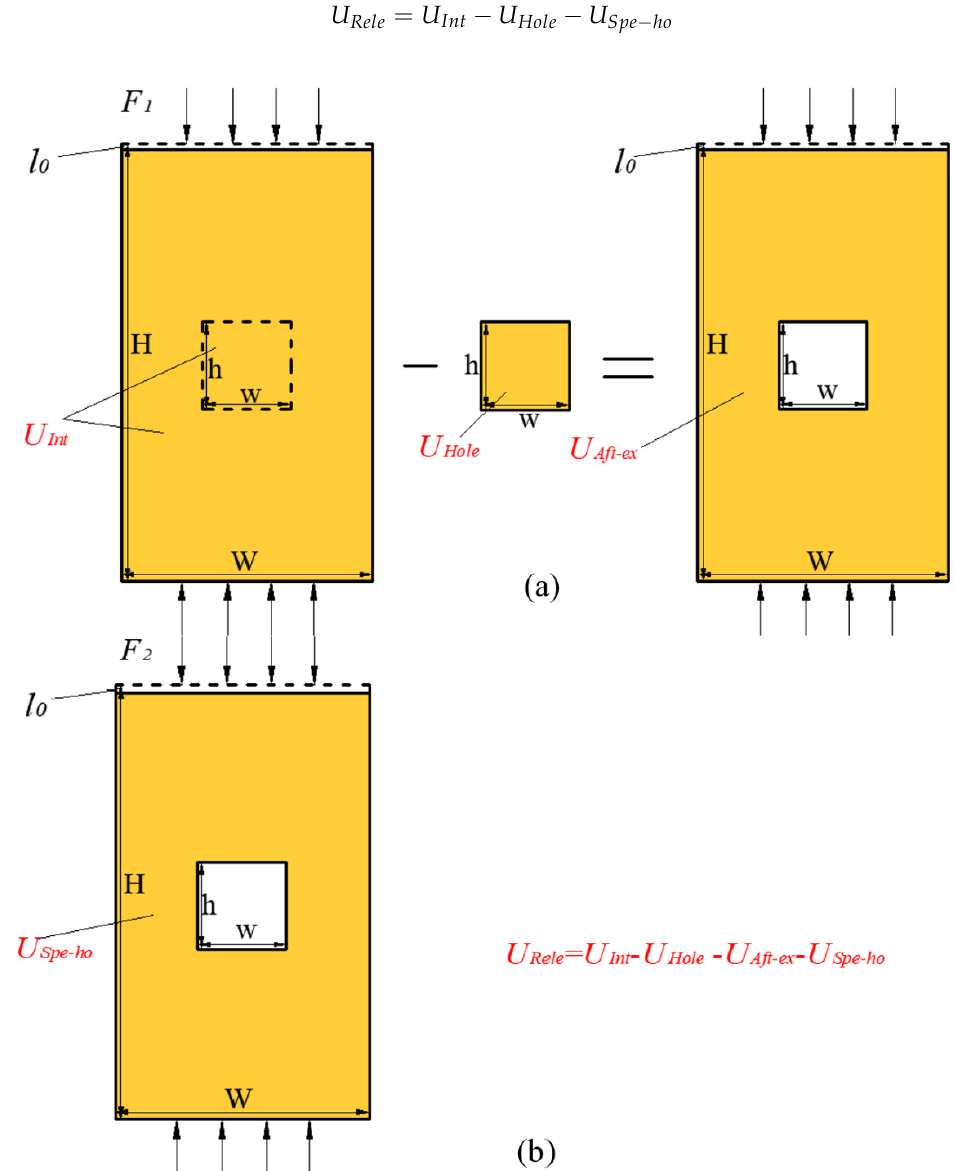
Figure 2. The intact specimen and specimen with a hole under the same compression deformation l 0 . ( a ). Excavation of hole after a certain deformation l 0 . ( b ). A certain deformation l 0 after excavation of hole.